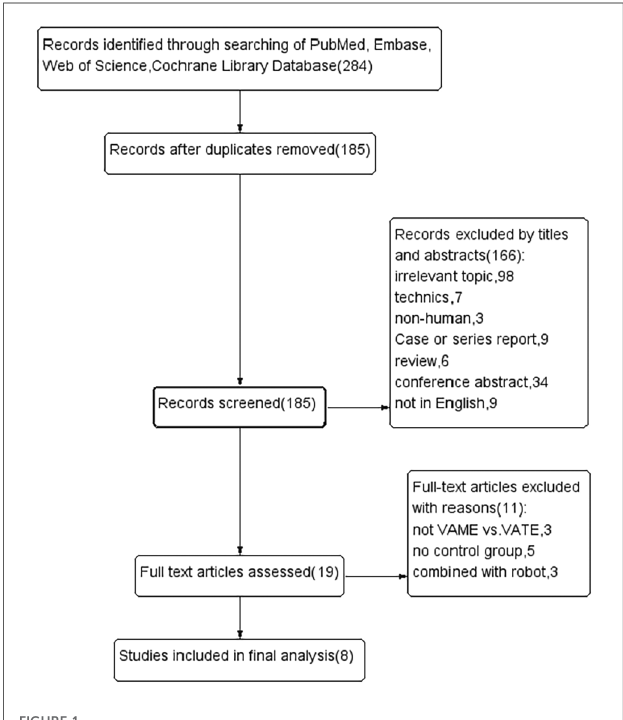
FIGURE 1 Flow diagram of selecting